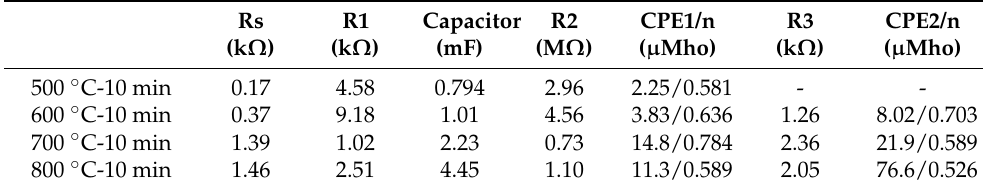
Figure 7. Nyquist ( a ) and Bode ( b ) and plots for heat treatments at 500 ◦ C, 600 ◦ C, 700 ◦ C, and 800 ◦ C with blue, red, green and orange, respectively. The dots are EIS data, and the line is the simulated equivalent circuit. Table 5. Results of equivalent circuit